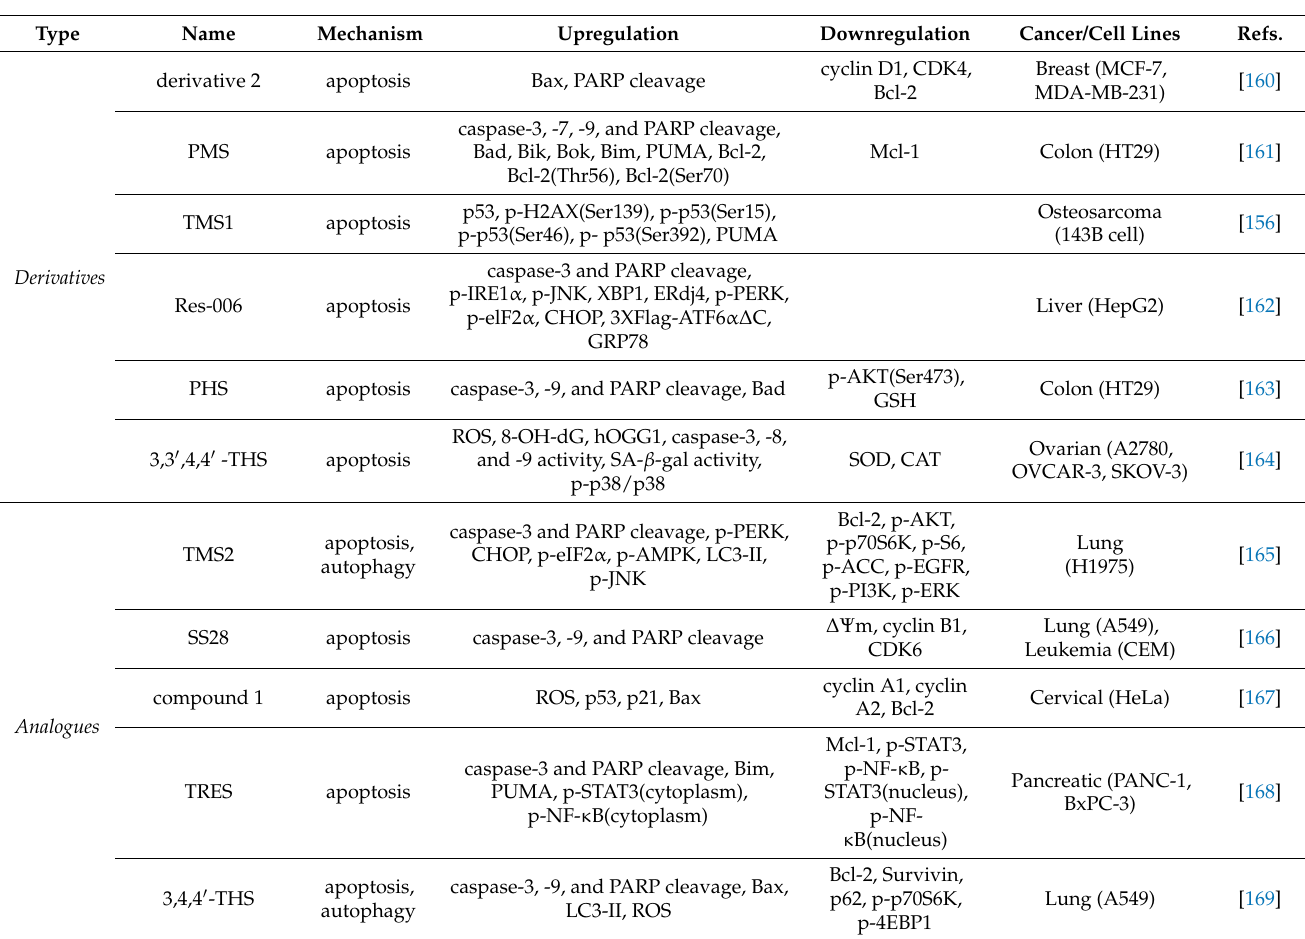
Table 3. Molecular targets of synthetic resveratrol derivatives and analogues for the induction of programmed cell